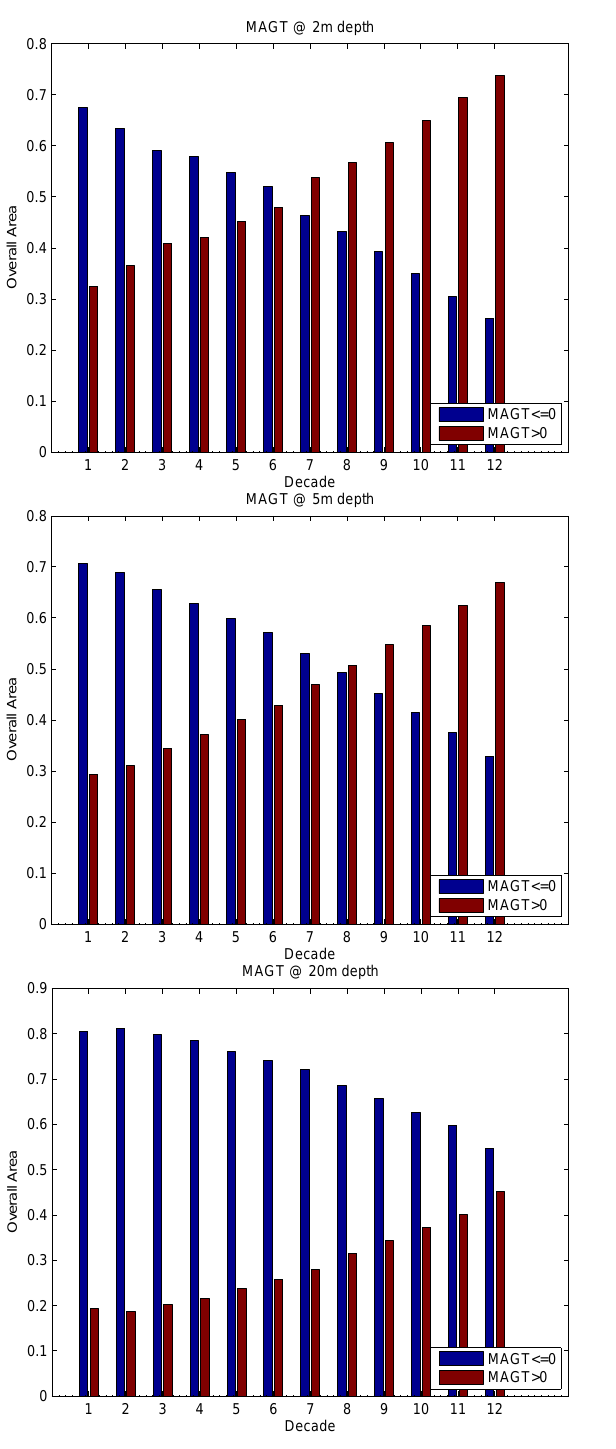
Fig. 11. The amount of area over entire State of Alaska occupied by colder and warmer than 0 ◦ C MAGTs averaged over ten years time interval from 1980 to 2099 at different ground depths.